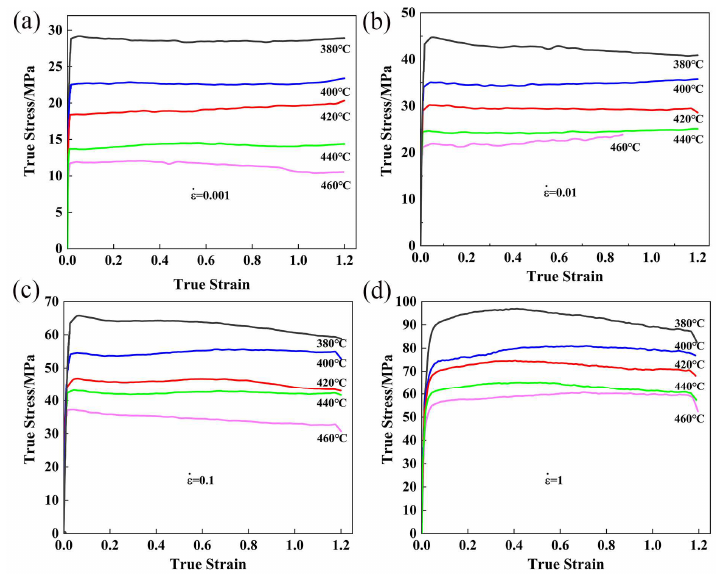
Figure 3. The curves of true stress–true strain curves of Al–10.0Zn–3.0Mg–2.8Cu alloy ( a ) 0.001 s − 1 , ( b ) 0.01 s − 1 , ( c ) 0.1 s − 1 , and ( d ) 1 s − 1 .